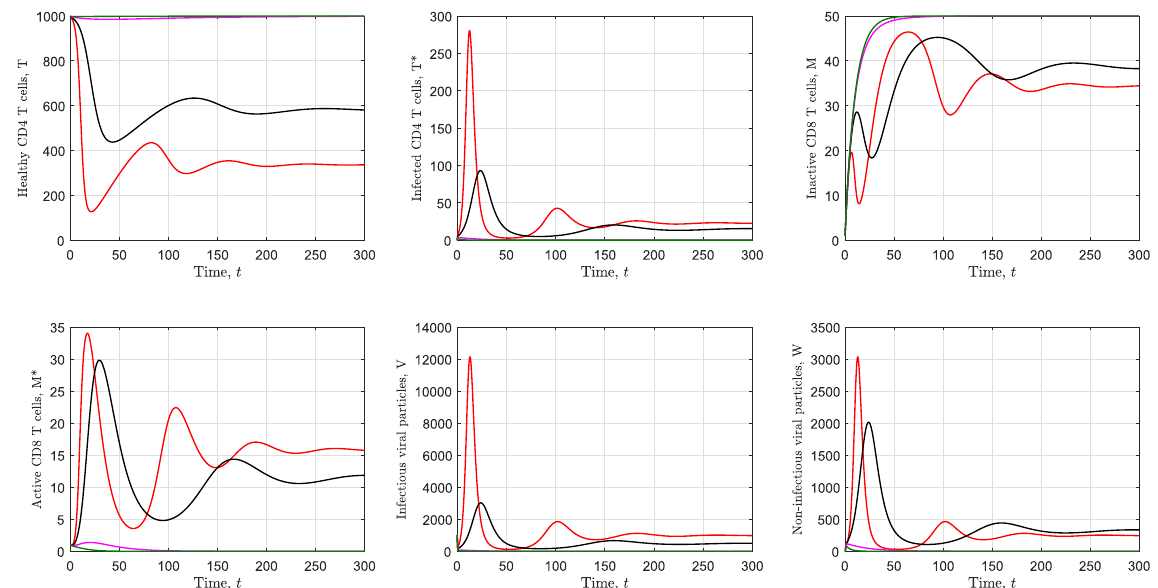
Figure 6. Numerical solutions of system (7) considering the parameters from Table 2, γ = 2 × 10 − 3 , β = 2.5 × 10 − 5 , and varying the values for ART effectiveness, under the assumption of being u 1 = u 2 . The red curve represents u i = 0.2, where R 0 = 1.2979, the black curve corresponds to u i = 0.4, with R 0 = 0.7301, the magenta curve to u i = 0.6 and R 0 = 0.3245, and the green curve is u i = 0.8 with R 0 = 0.0811, for i =